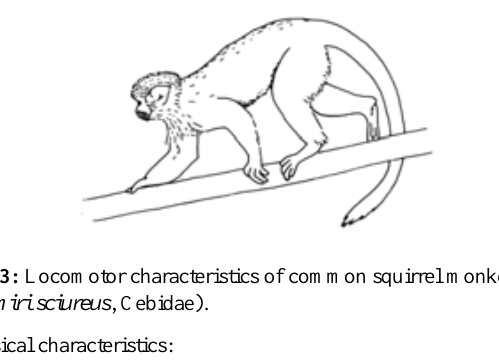
Figure for Box 3